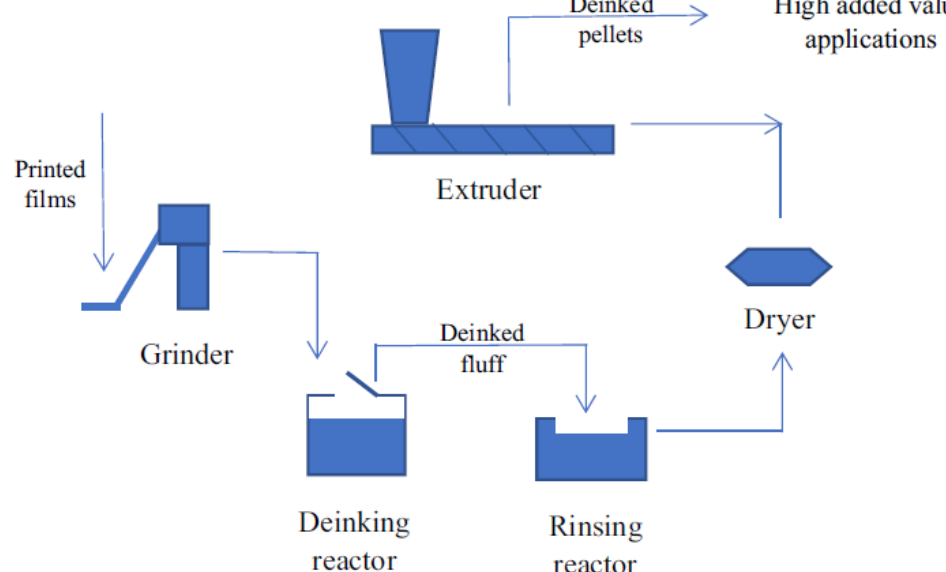
Figure 5. Cadel Deinking process of printed films, developed by the University of Alicante. Reprinted from publication [2]. Copyright 2018, with the permission from Elsevier. (A color version of this figure can be viewed online).